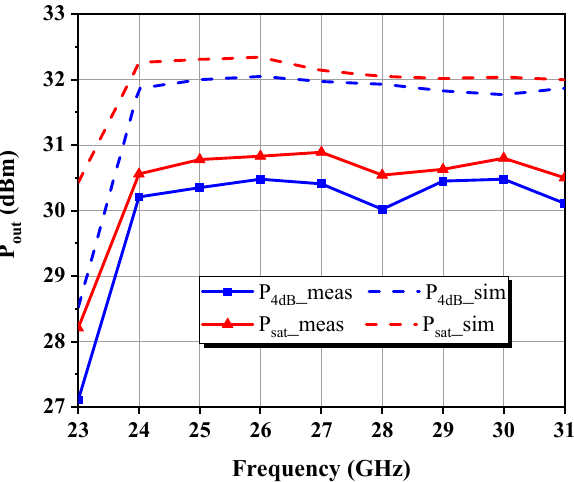
Figure 18. Measured and simulated P out at 4 dB gain compression and in the saturation state.